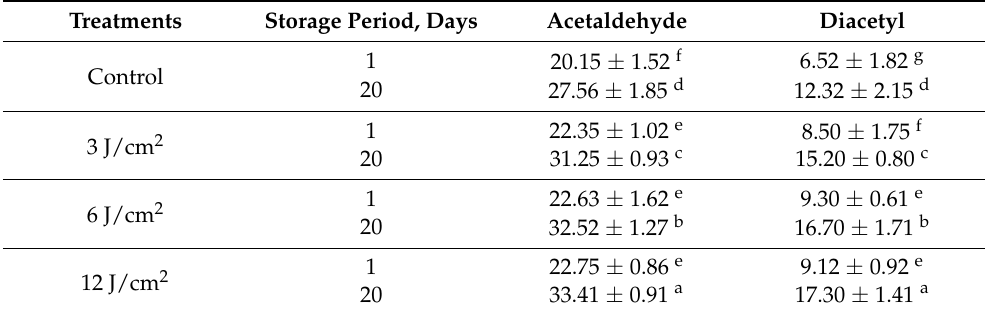
Changes in the acetaldehyde and diacetyl profiles ( µ mol.100 g − 1 ) of different labneh